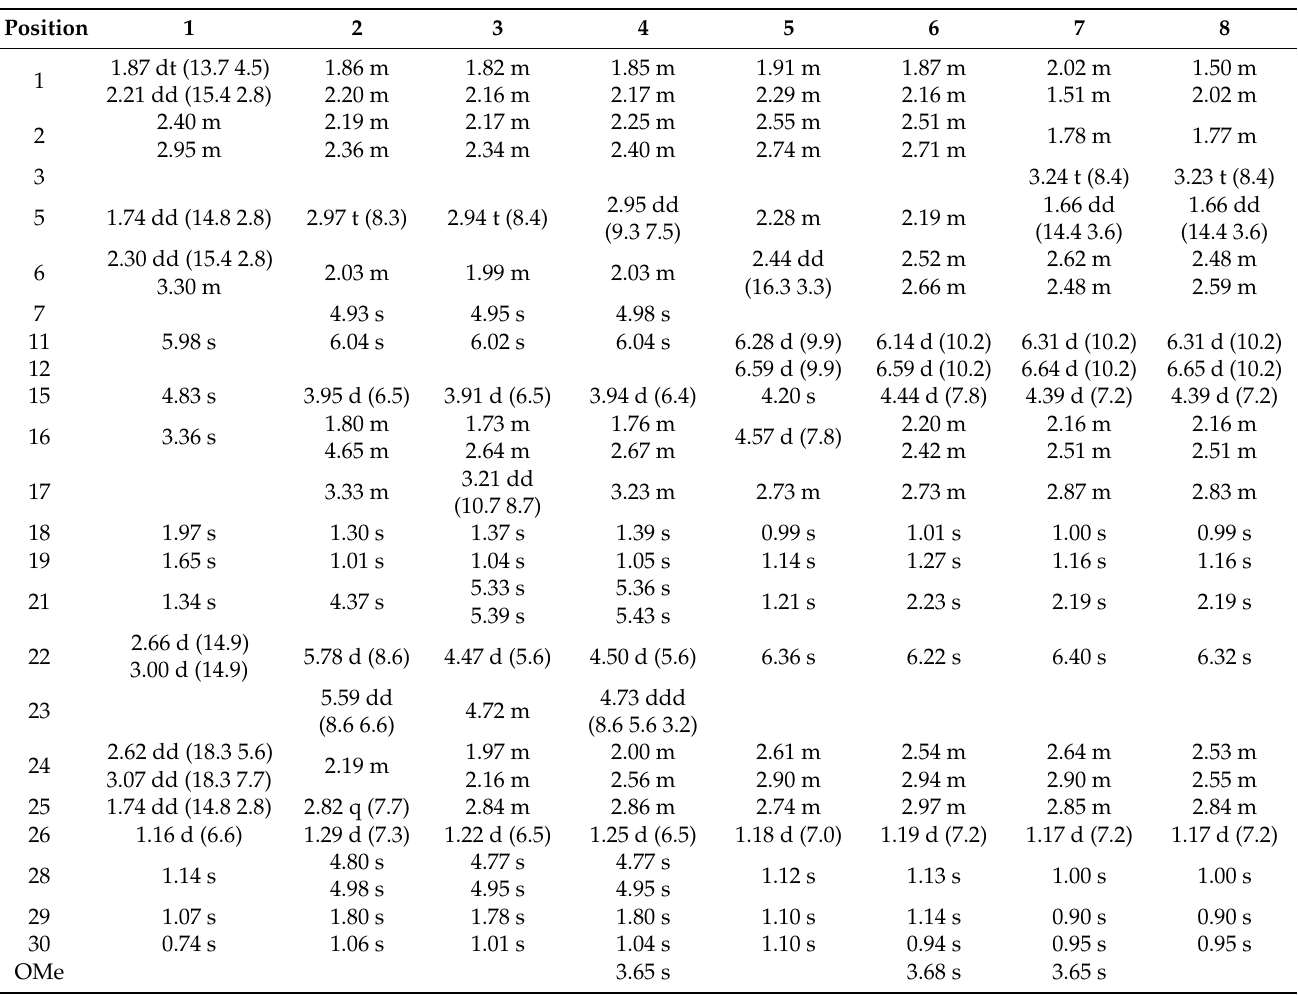
Table 1. 1 H NMR spectra of compounds 1 – 8 (600 MHz, methanol- d 4 , J in Hz, δ in ppm